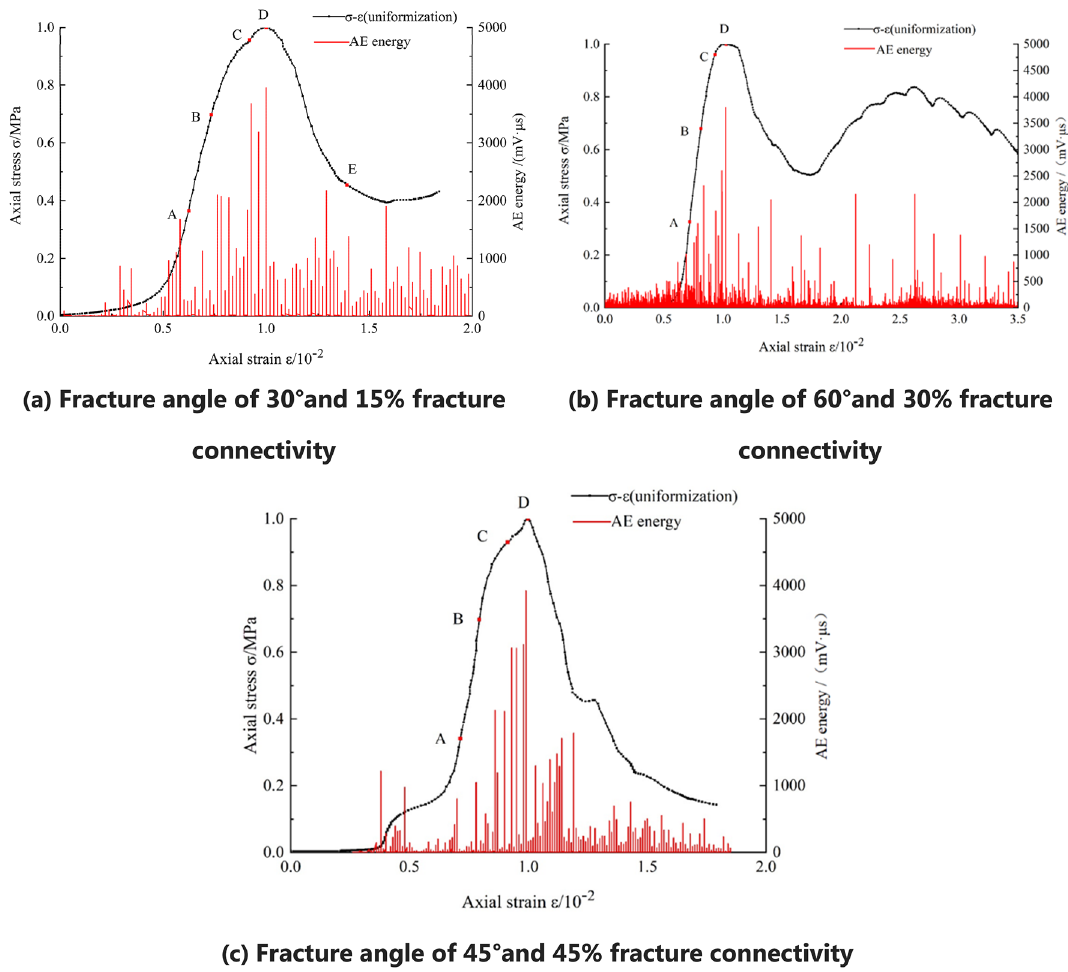
Figure 7. Stress–strain curves and acoustic emission characteristics of the fractured soft rock-like the loading continues, the secondary cracks start to expand and connect, thus forming macroscopic cracks. The elastic deformation changes to irreversible plastic deformation, and the specimen enters the stable fracture development stage, accompanied by a pronounced AE signal. As the load continues to increase, the interactions between internal cracks are enhanced and macroscopic cracks propagate until the whole specimen fails. At this time, the specimen is in the unstable fracture development stage. The AE generated in the stage is more sudden and tends to increase gradually. Near the peak strength, the AE signal is active and energy release is maximal at peak strength. As the specimen enters the post-peak failure stage, the stress–strain curve begins to decline and the AE signal decreases. The stress–strain curves can be divided into three stages: (1) When the fracture connectivity is either small (15%) or medium (30%) and the angle is small (30° or 45°), or the connectivity is high (45%) and the angle is small (30°), an upward trend is observed in the post-peak failure stage, as shown in Fig. 7a. (2) When the fracture has medium connectivity (30%) and a large angle (60°), a secondary peak appears in the post-peak failure stage, as shown in Fig. 7b. (3) When the fracture connectivity is large (45%) and the angle is large (45° or 60°), there is no secondary peak phenomenon or trend in the post-peak failure stage of fractured soft rock, which is similar